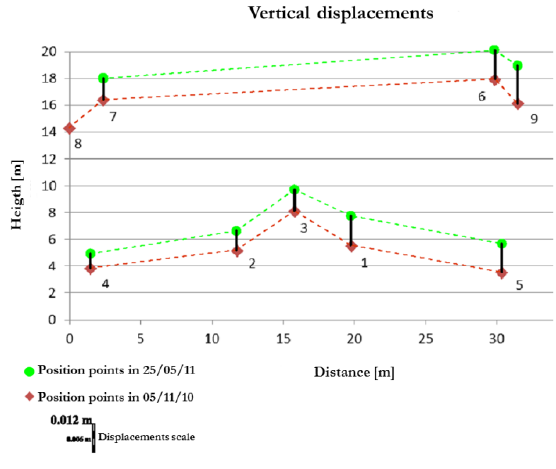
Figure 13. Vertical displacement vectors in West